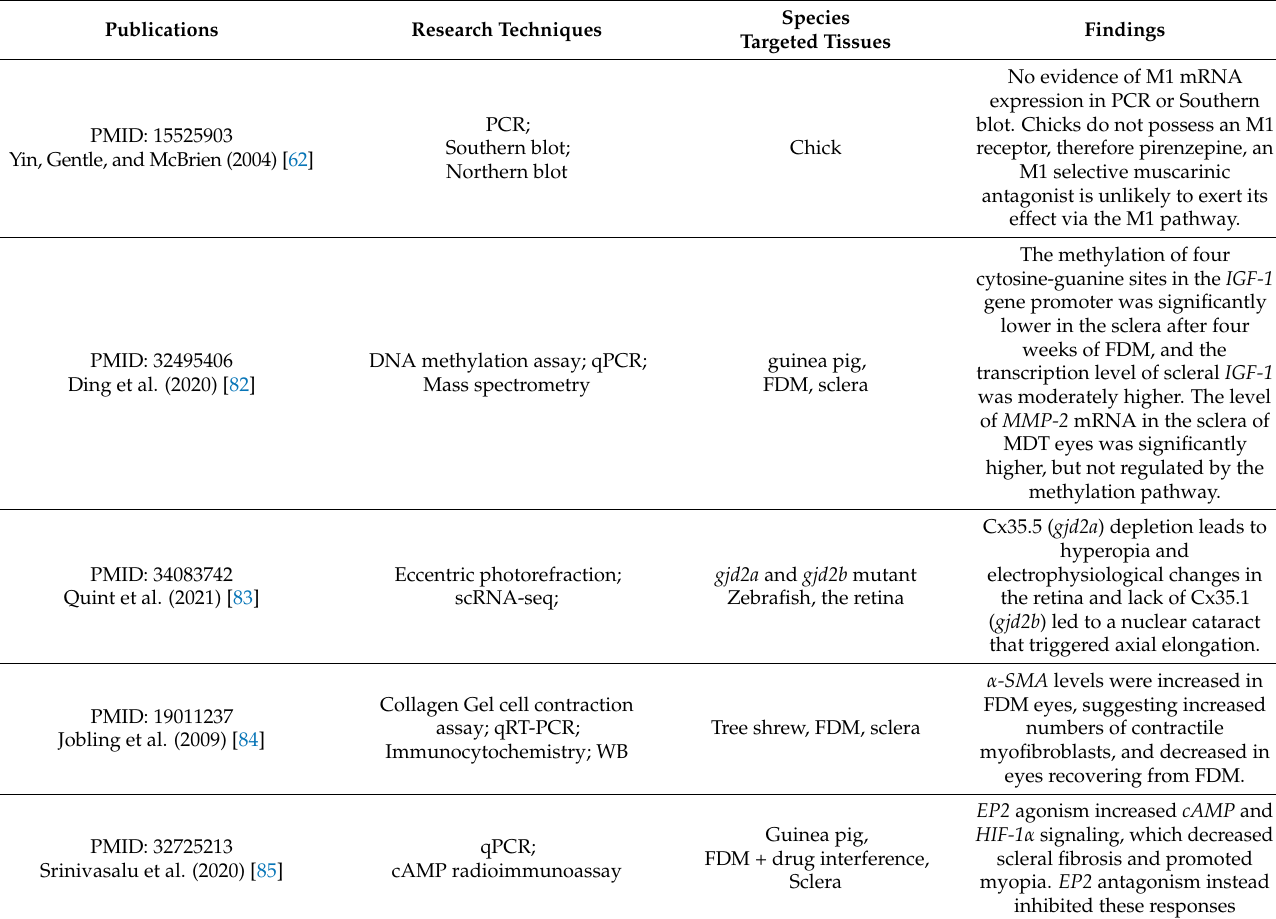
Table 4. Targeted genes in myopia animal